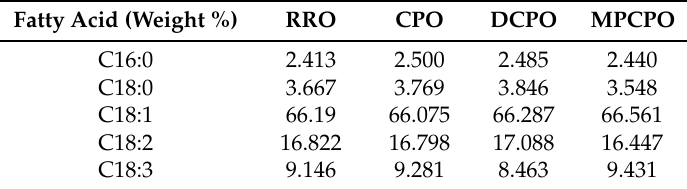
Table 2. Major fatty acid compositions in different rapeseed